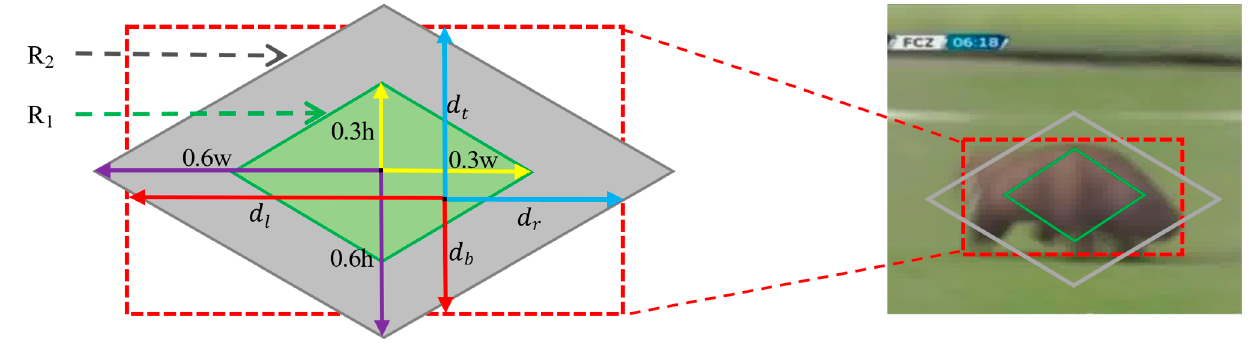
left, top, right, and bottom bounding box, respectively, as shown in Figure 3.